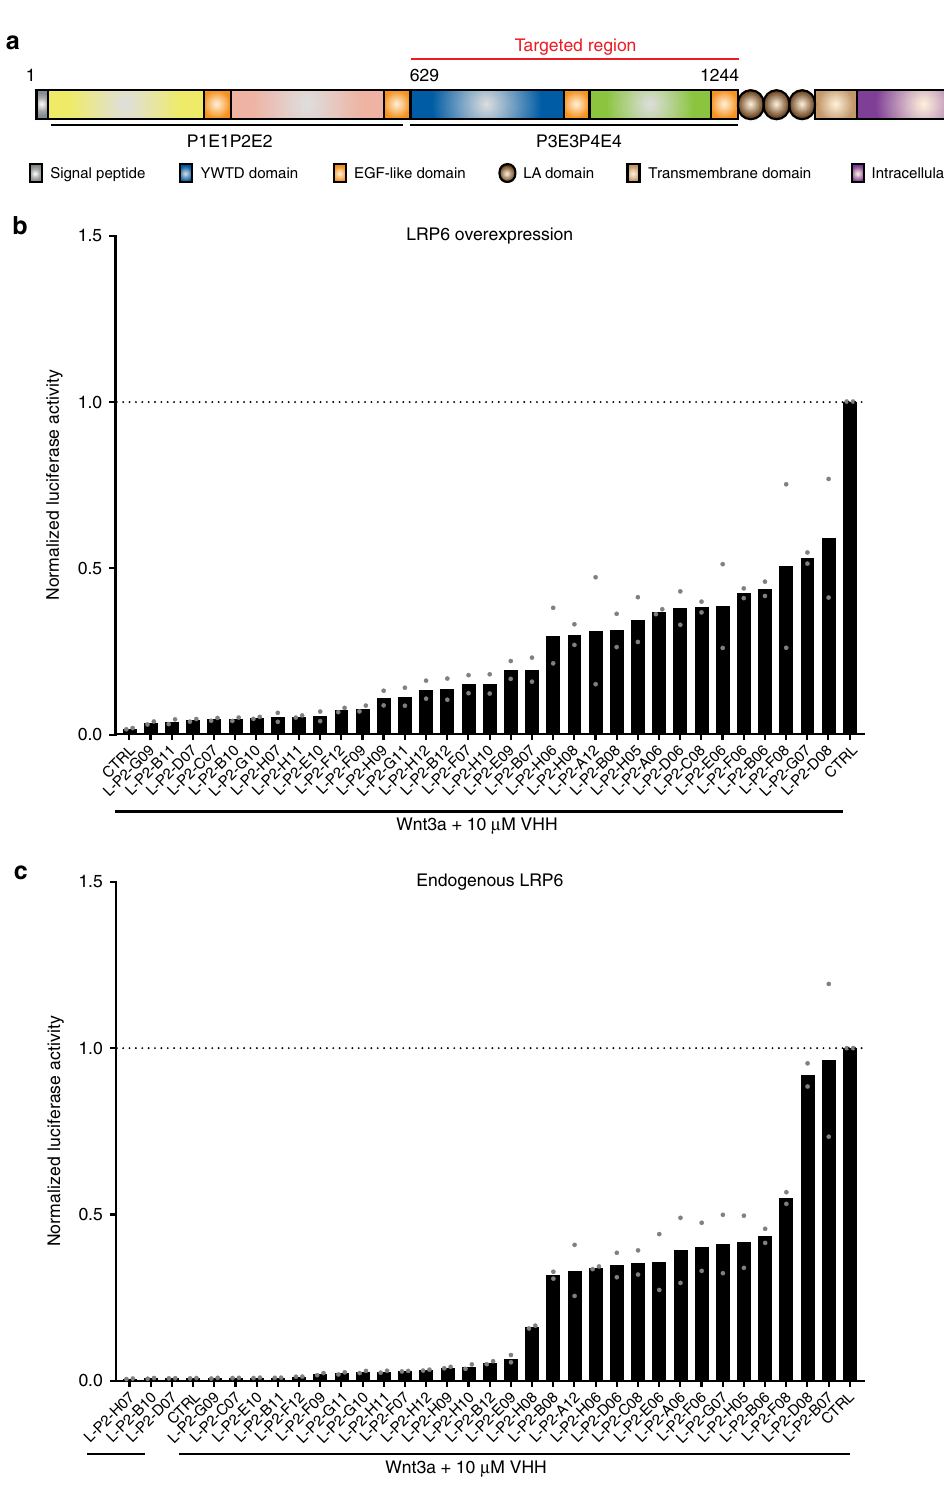
Fig. 1 VHHs targeting LRP6 P3E3P4E4 block cellular responses to Wnt3a. a Schematic representation of LRP6. The P3E3P4E4 module of the